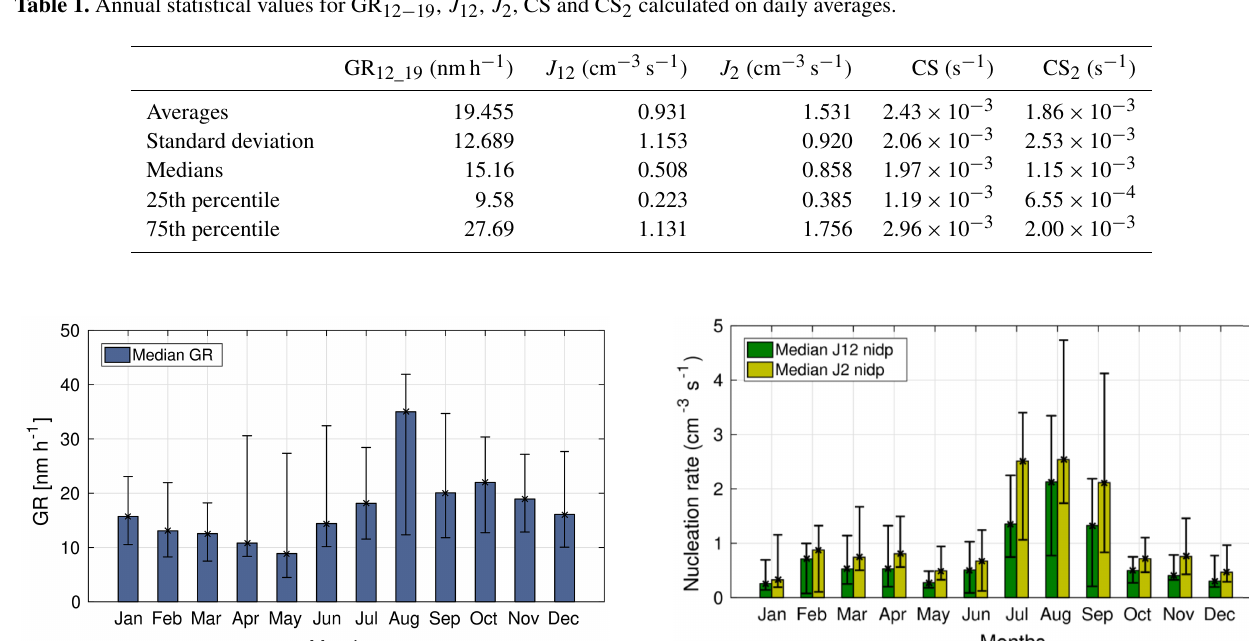
Table 1. Annual statistical values for GR 12 − 19 , J 12 , J 2 , CS and CS 2 calculated on daily averages.